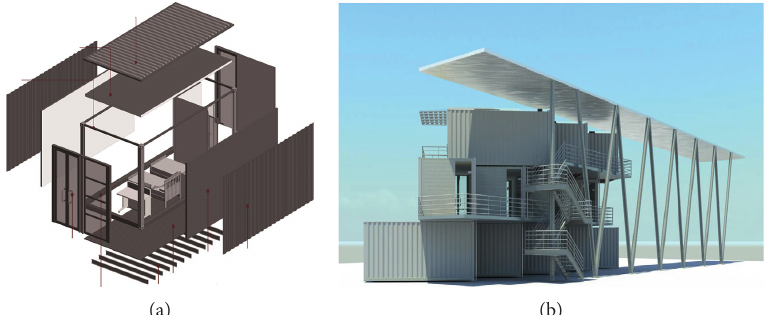
Figure 6: BIM model of modular steel structure buildings. (a) A single module. (b) Combination of modules, components, and parts of a modular steel structure building.